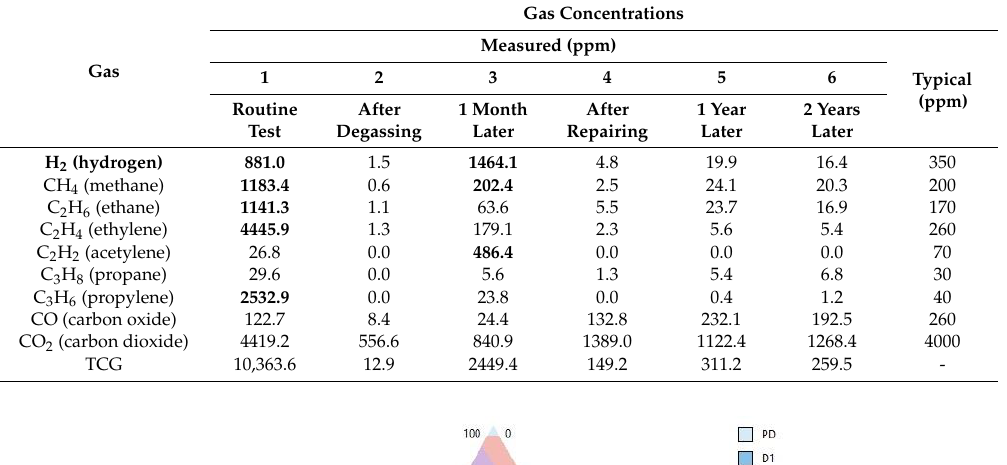
Table 10. Gas concentrations measured for the oil samples taken from a 2.7 MVA, 30 / 0.66 kV power transformer (exceedance of the typical values is marked in bold font).